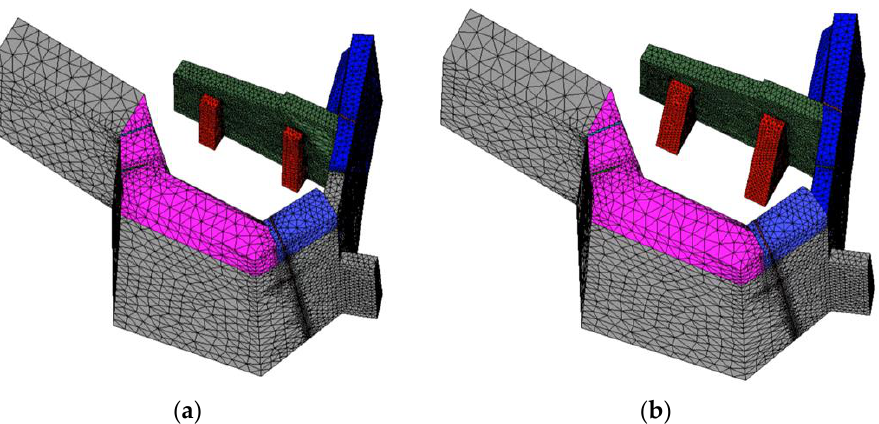
Figure 27. View of the mesh in GID 14, showing the two different configurations of buttresses: ( a ) buttress type A; ( b ) buttress type B.